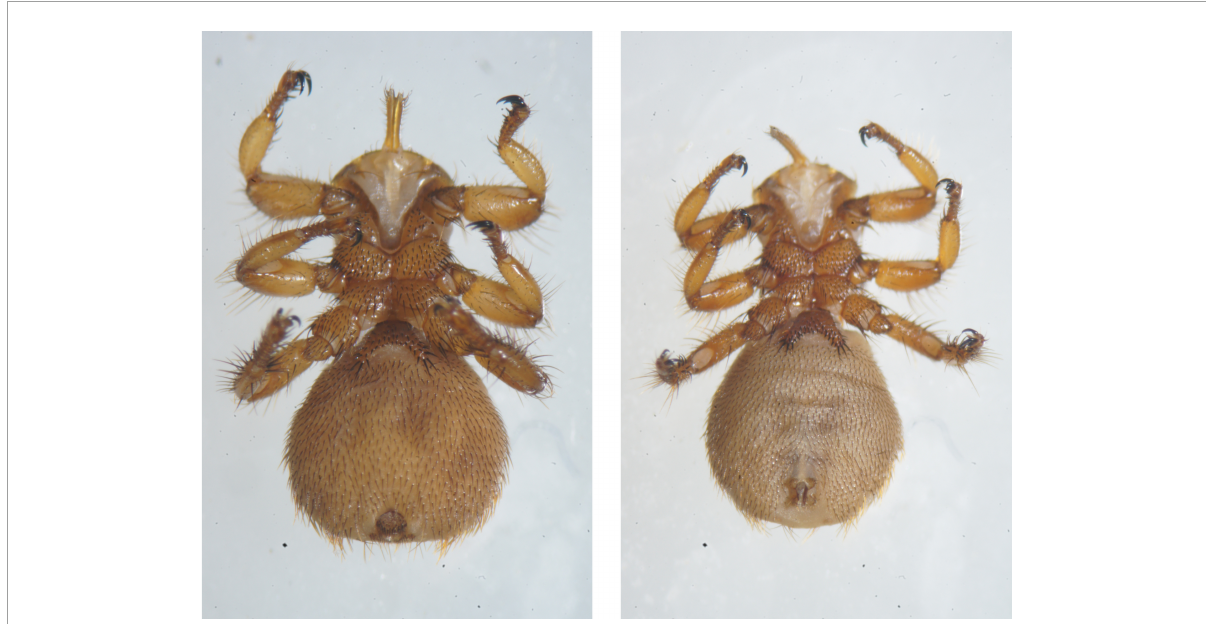
FIGURE1 Photomicrographs of Melophagus ovinus (Left: Ventral view of the female; Right: Ventral view of the male).